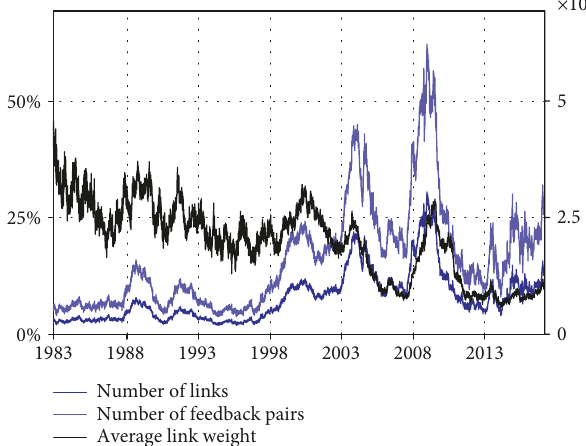
Figure 5: Number of links (shown in dark blue, scale on the left axis), and the number of feedback pairs (light blue, left axis) as a percentage of total possible links/pairs, and the average link weight (black, right axis) for the causality networks estimated from the U.S. stock market data on a rolling time window of T = 1 year.